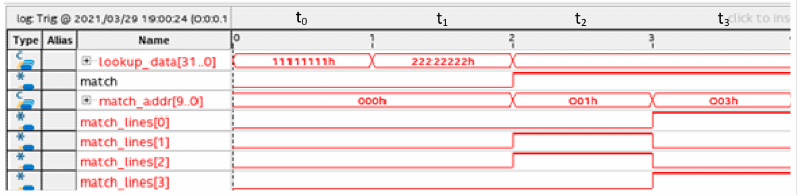
Figure 20. Real-time-captured operating